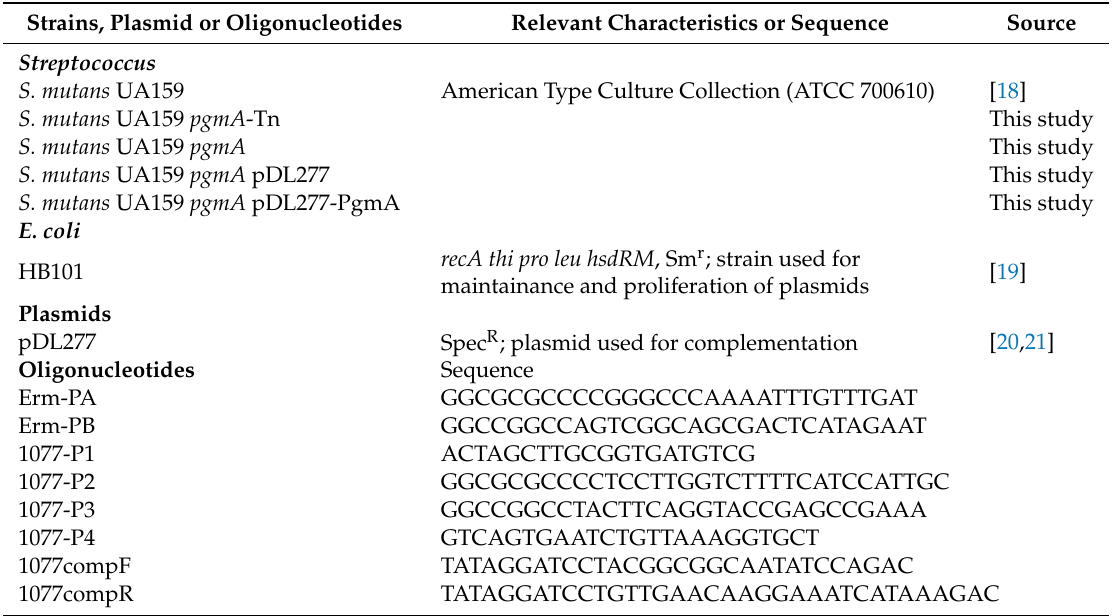
Table 1. Strains, plasmids and oligonucleotides used in this